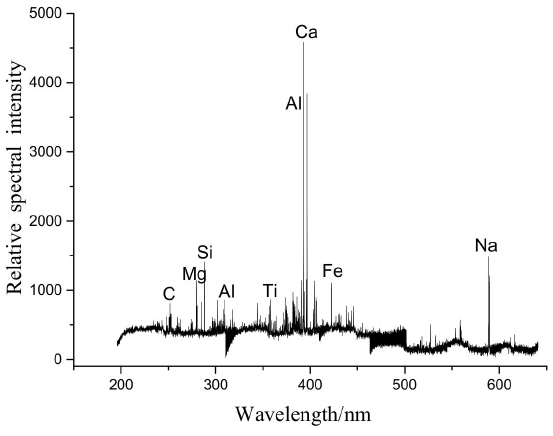
Figure 2. LIBS spectrum of the natural pollutions. Table 2. Wavelength of typical spectral lines for pollutions element by